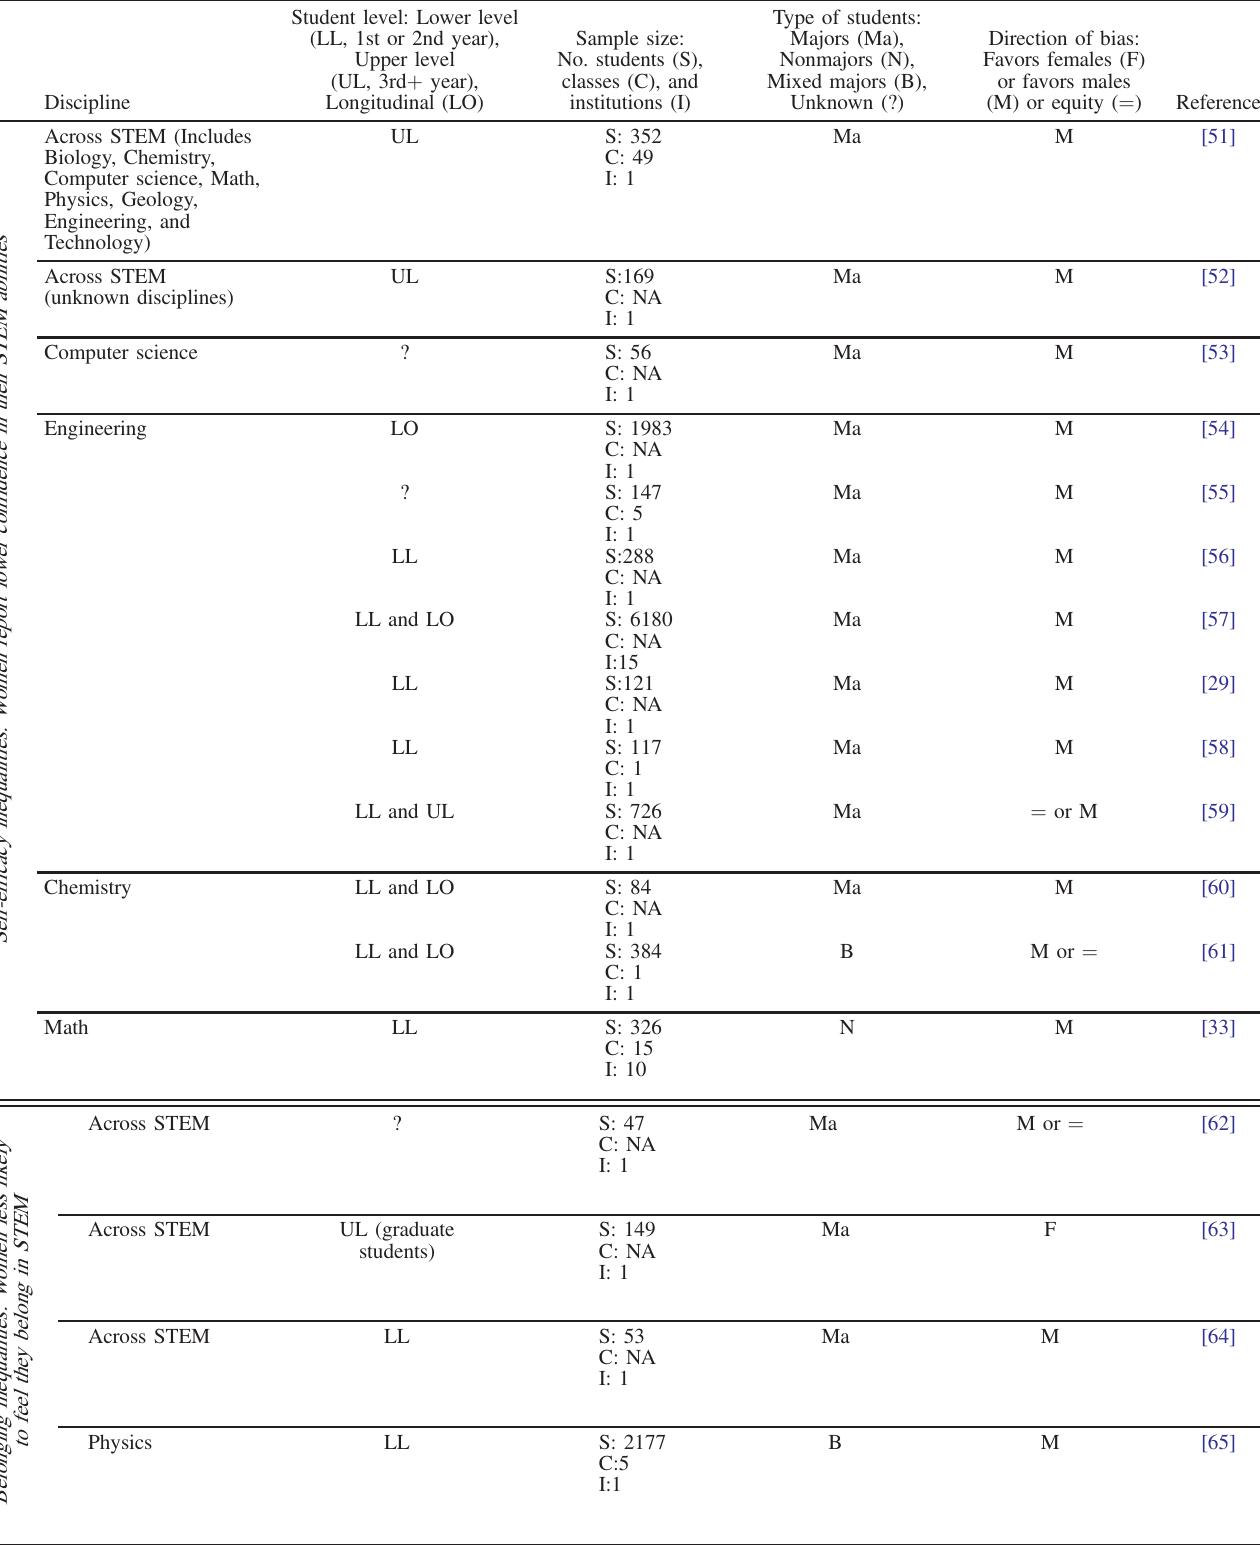
TABLE II. Survey of articles reporting on gender gaps in affective measures in STEM majors or STEM